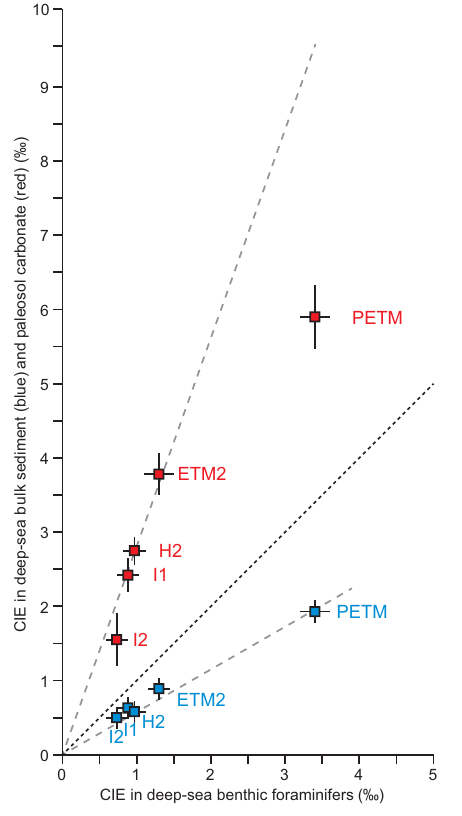
Figure 4. Carbon isotope excursions (CIEs) for the PETM, ETM2, H2, I1, and I2 events in the early Eocene compared between differ- ent proxies in marine and terrestrial settings. Blue squares denote benthic foraminiferal ( x axis) versus bulk sediment ( y axis) CIEs at Walvis Ridge in the Atlantic Ocean. Red squares denote benthic foraminiferal ( x axis) CIEs at Walvis Ridge versus paleosol car- bonate ( y axis) CIEs in the Bighorn Basin, Wyoming (USA). Trend lines are forced through the origin. Note the apparently reduced CIE for the PETM in paleosol carbonate if extrapolation of the trend line through ETM2, H2, I1, and I2 is